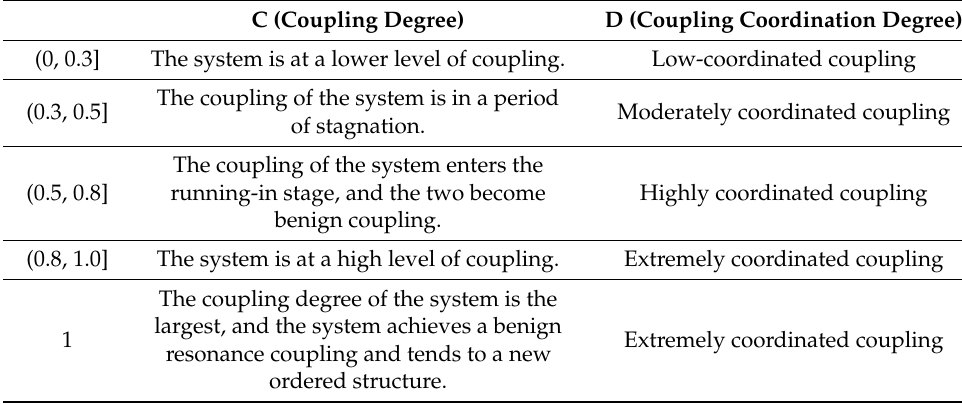
Table 5. Value range and corresponding explanation of coupling degree and coordination degree.